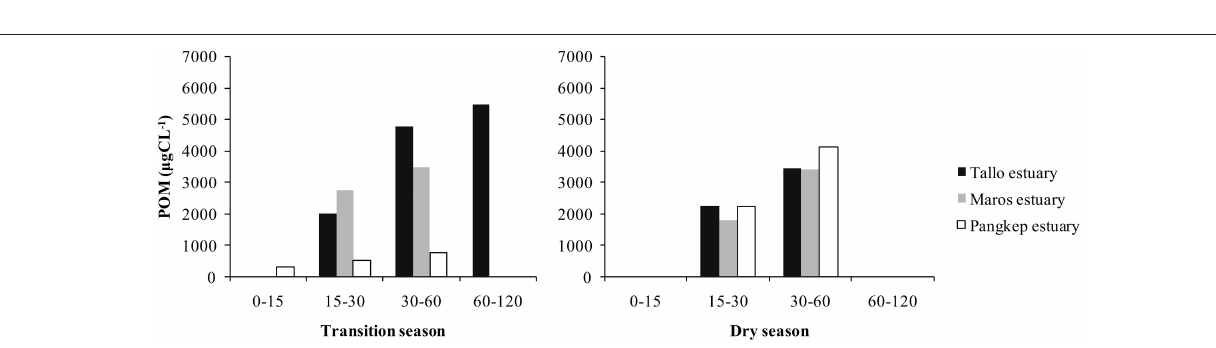
FIGURE 3 | Correlation of SPM with C/N ratio on the west coast of South Sulawesi. Transition Season (April 2013); Dry Season (June 2013).